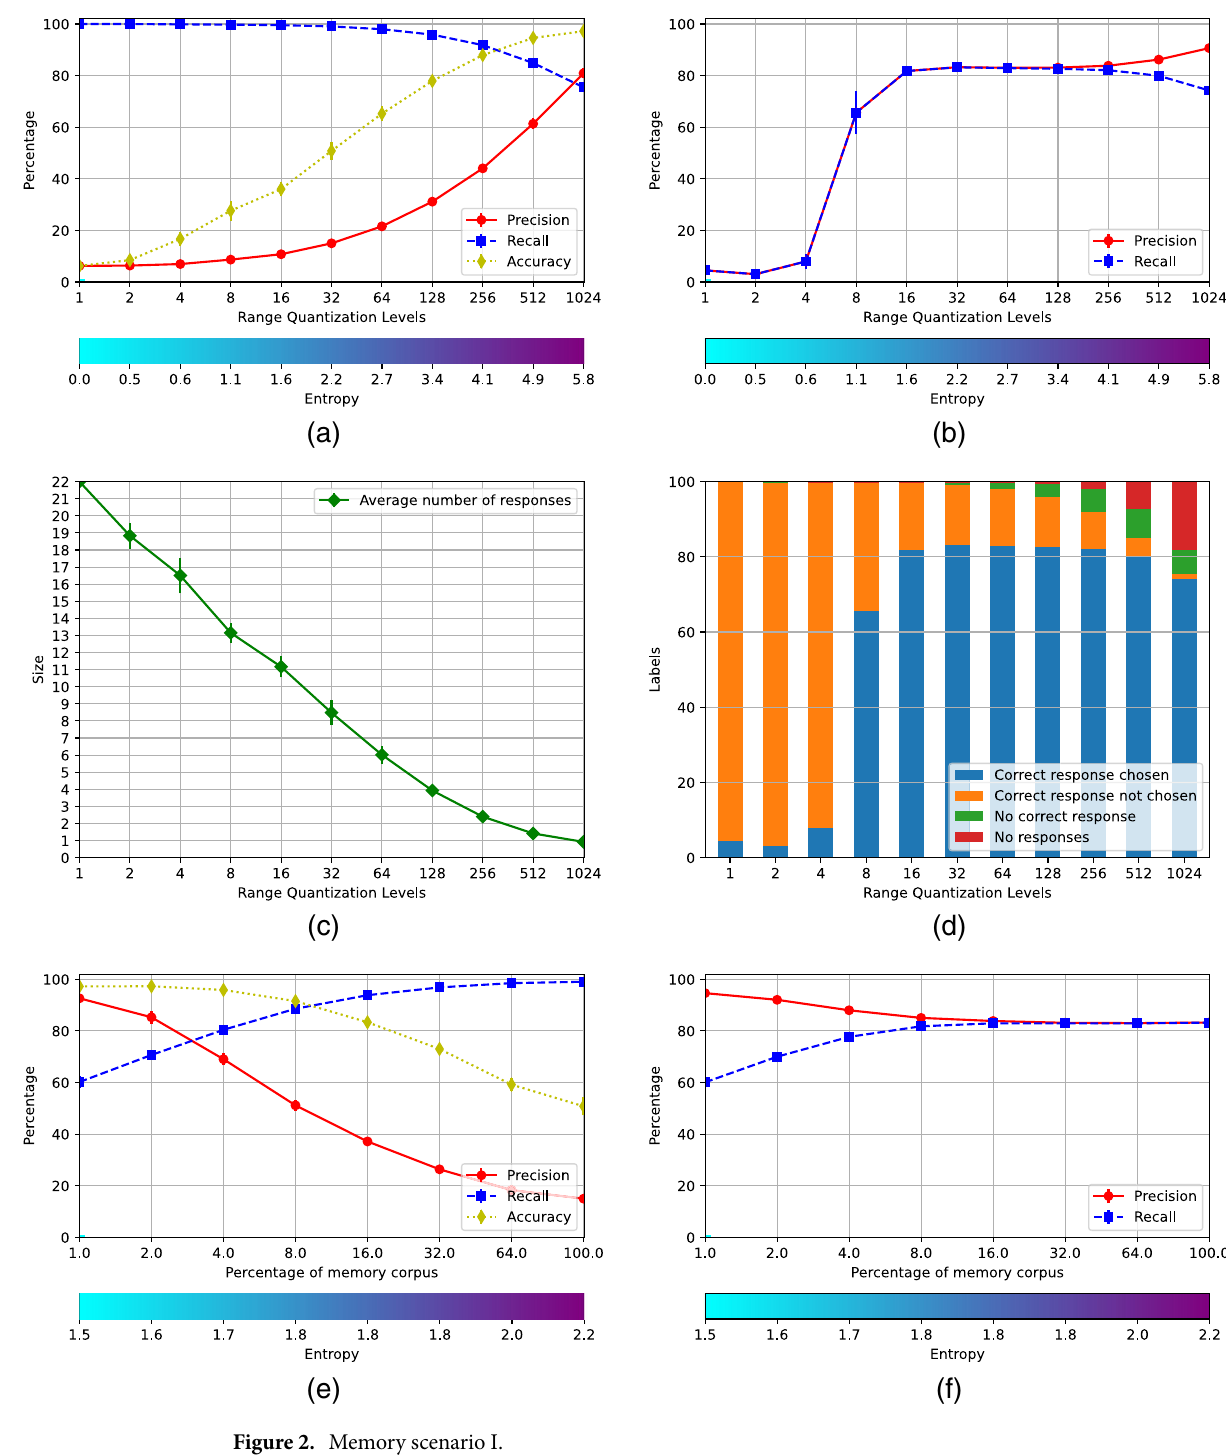
Figure 2. Memory scenario